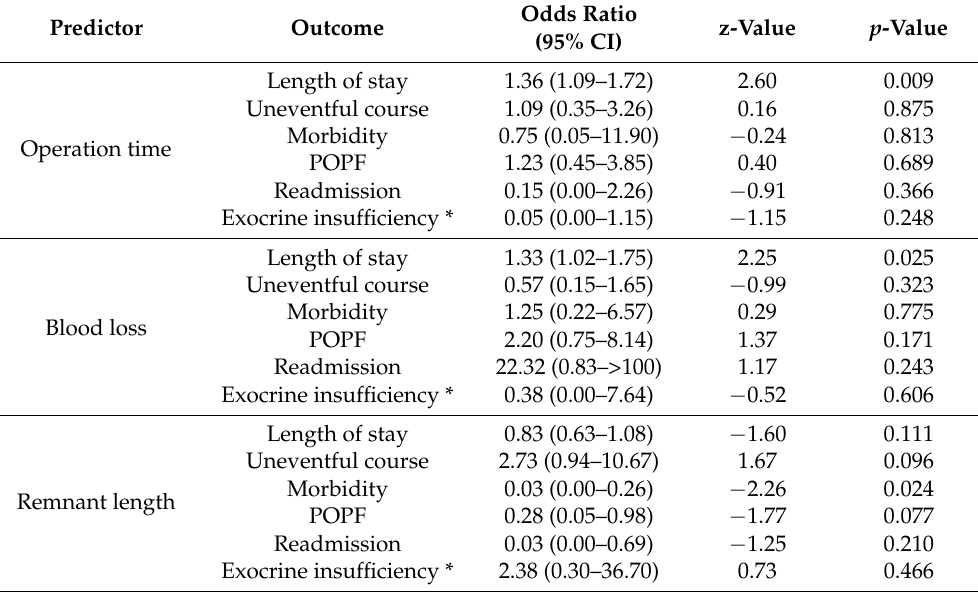
Table A7. Effects of surgical outcomes in selected models. Predictor